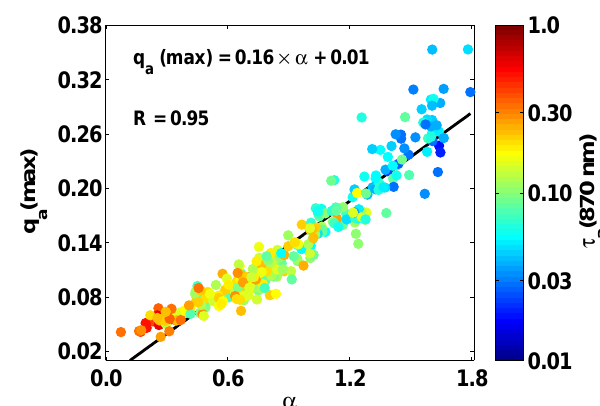
Mixed ( 0 . 6 ≤ α ≤ 1 . 2 ) Total 0.02 0.59 0.14 100 Fig. 4. Retrieved q a at 870nm versus the scattering angle in the atmosphere of Zanjan for two measurements with same τ a and dif- ferent α , IASBS site.